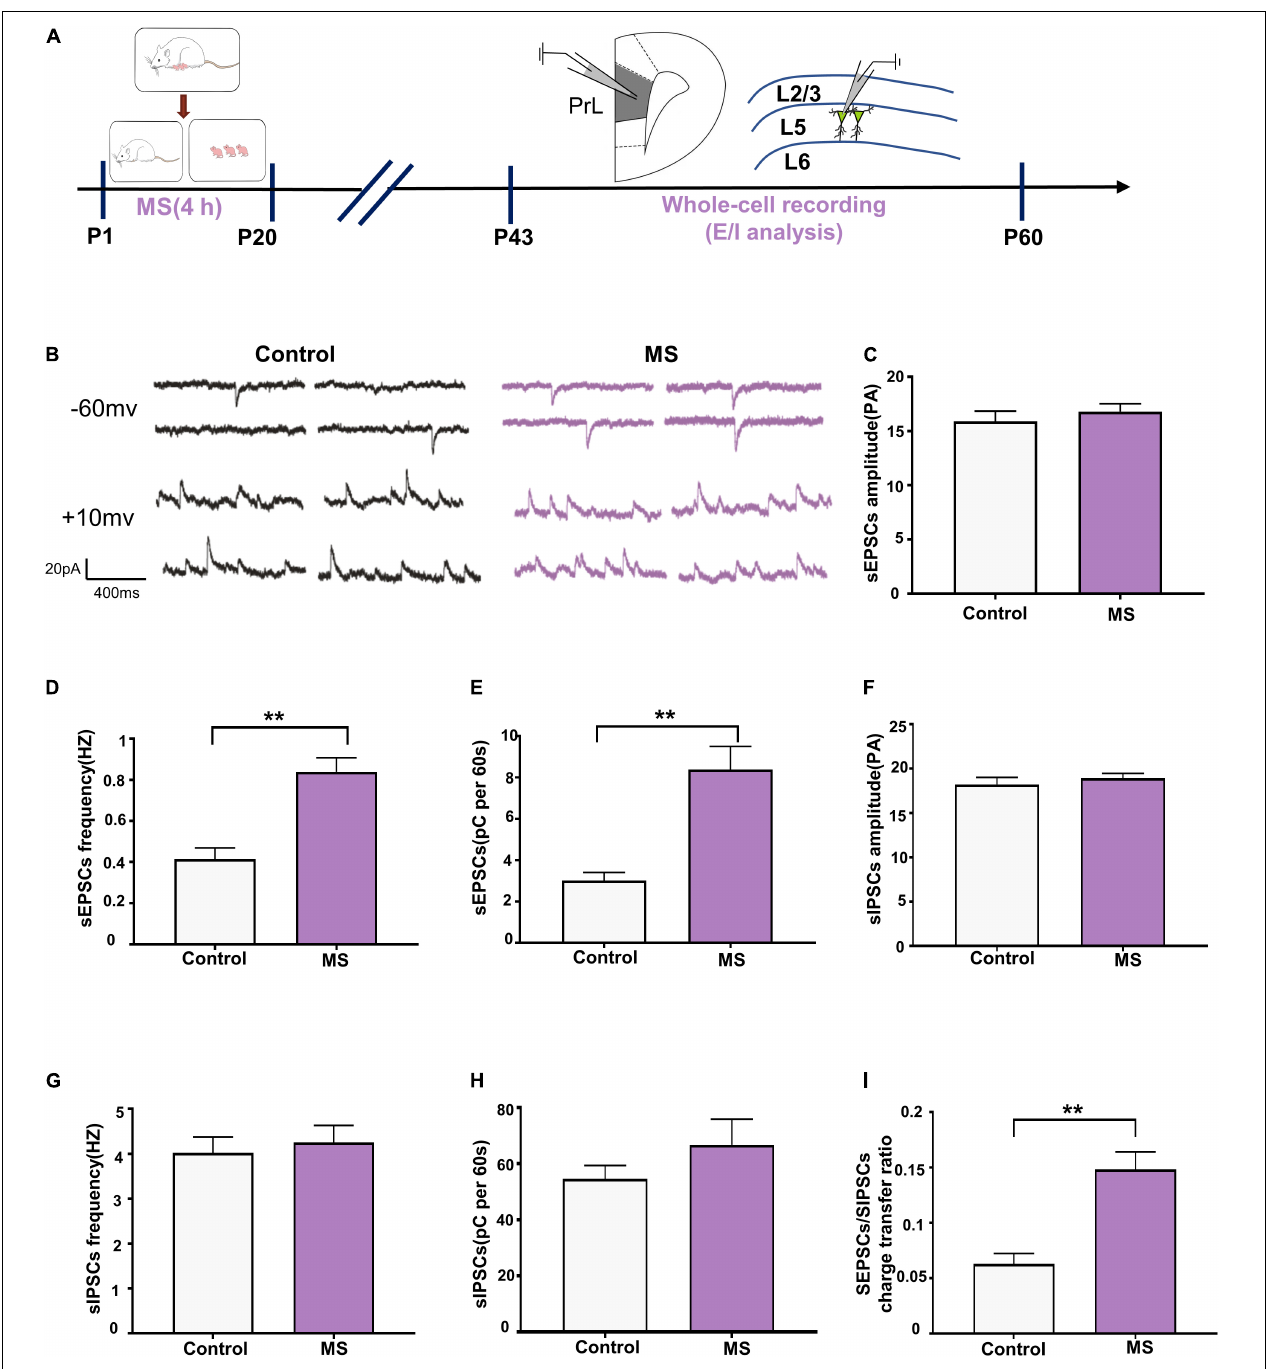
FIGURE 4 | Increased E/I balance of L5 pyramidal cells in adolescent MS rats. (A) The experimental timeline of MS, whole-cell recording (E/I analysis). (B) Representative sEPSC (upper) and sIPSC (lower) current traces at a holding potentiation of –60 and + 10 mV, respectively. Scale bars: 20 pA, 400 ms. (C–E) Changes in the amplitude, frequency, and quantification of sEPSC current recorded by isolated patch clamp in adolescent rats. (F–H) Changes in the amplitude, frequency, and quantification of sIPSC current recorded by isolated patch clamp in adolescent rats. (I) sEPSC/sIPSC charge transfer ratios. * p < 0.05, ** p < 0.01. Data are the means ± SEM ( n = 18 cells from 3 to 4 rats each